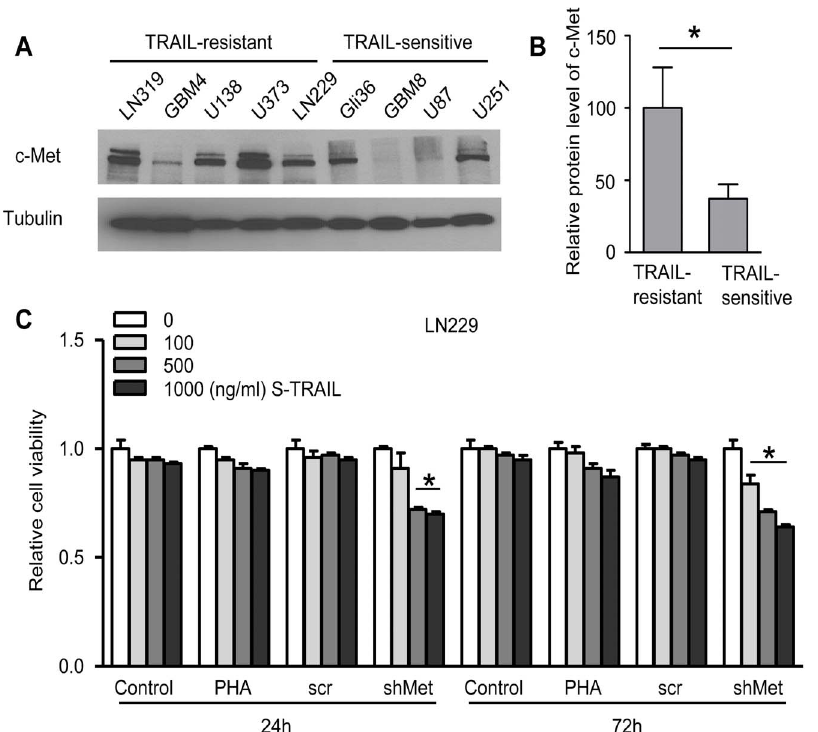
Figure 2. Knock down of c-Met protein sensitizes resistant glioma cells to S-TRAIL treatment. (A) Western blot analysis of c-Met and tubulin levels in indicated glioma lines. (B) Plot showing the statistic results of c-Met protein levels in both TRAIL-resistant and TRAIL-sensitive glioma lines. (C) LN229 cell line viability analysis showing the effect of S-TRAIL treatment (24 h and 72 h) on indicated groups. * P , 0.05.